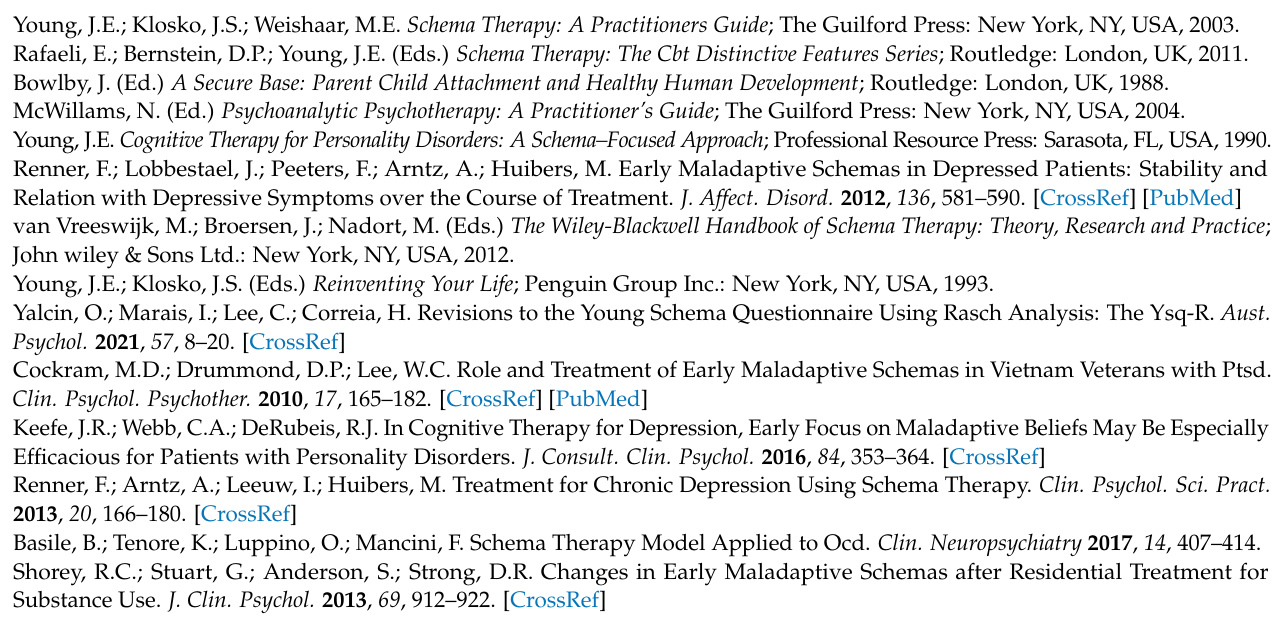
Table S9: Regression Analysis for Pre-Treatment YSQ Change and Symptom Change for Each YSQ Version and DASS-42 Subscales in the Alcohol and Substance Use